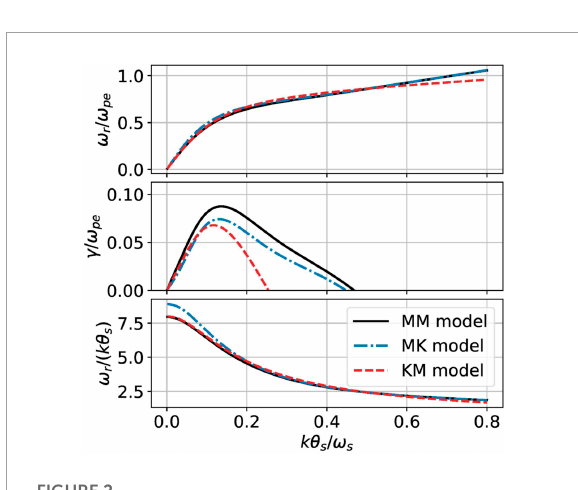
FIGURE 2 The wave frequency (upper panel), growth rate (middle panel), and wave speed (lower panel) of EAIs in the three models. The parameters are set as the same as those in Figure 1 . The real frequency ω r and growth rate γ are both scaled by the total plasma frequency ω pe = √ ω 2 s + ω 2 . f